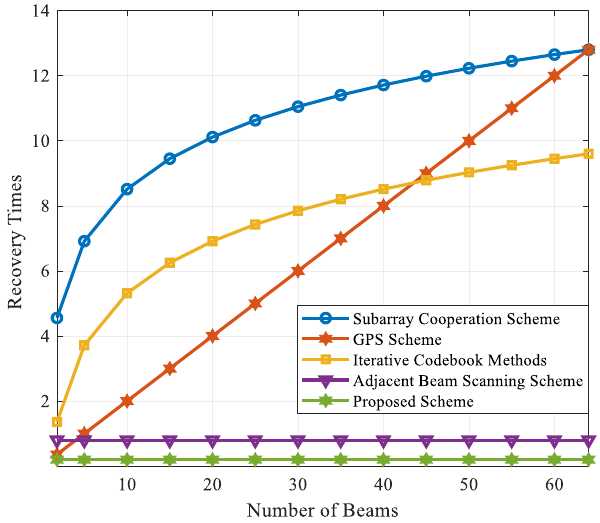
Figure 6. Power delay profile for proposed multi-backup scheme.